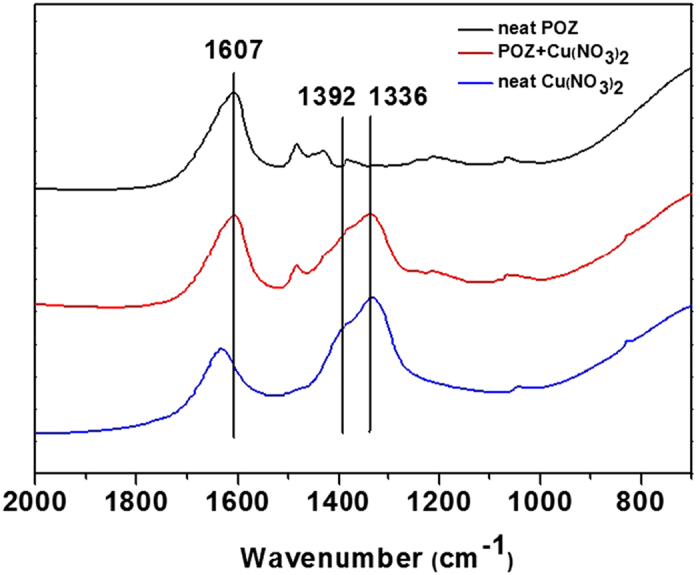
FT-IR spectra of neat POZ and POZ/Cu(NO3)2 electrolyte.